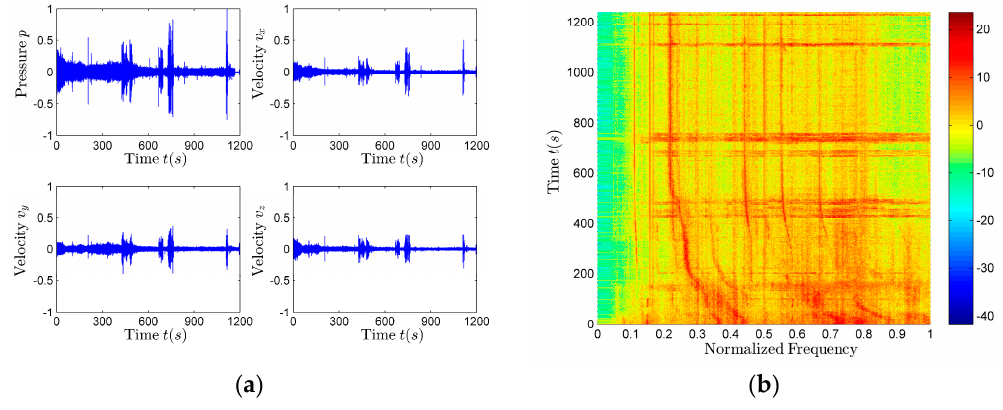
Figure 11. The time and frequency domain information of the signal. ( a ) The signal waveform; ( b ) The normalized spectrogram of v z signal.